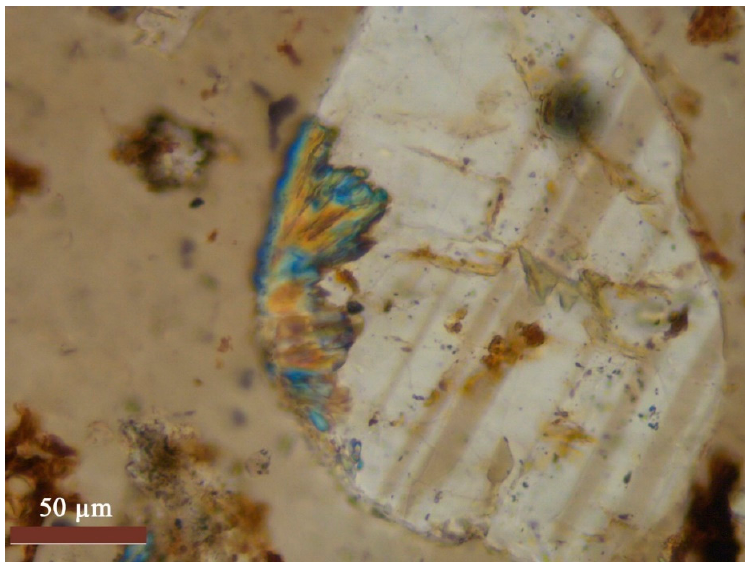
Figure 13. Seritization of feldspar mineral. Sardakh Island. S 3 (16–25 cm). Plane polarized light. Soils are influenced by physical weathering under cryogenic conditions of soil formation. The minerals are fractured (Figures 14 and 15).